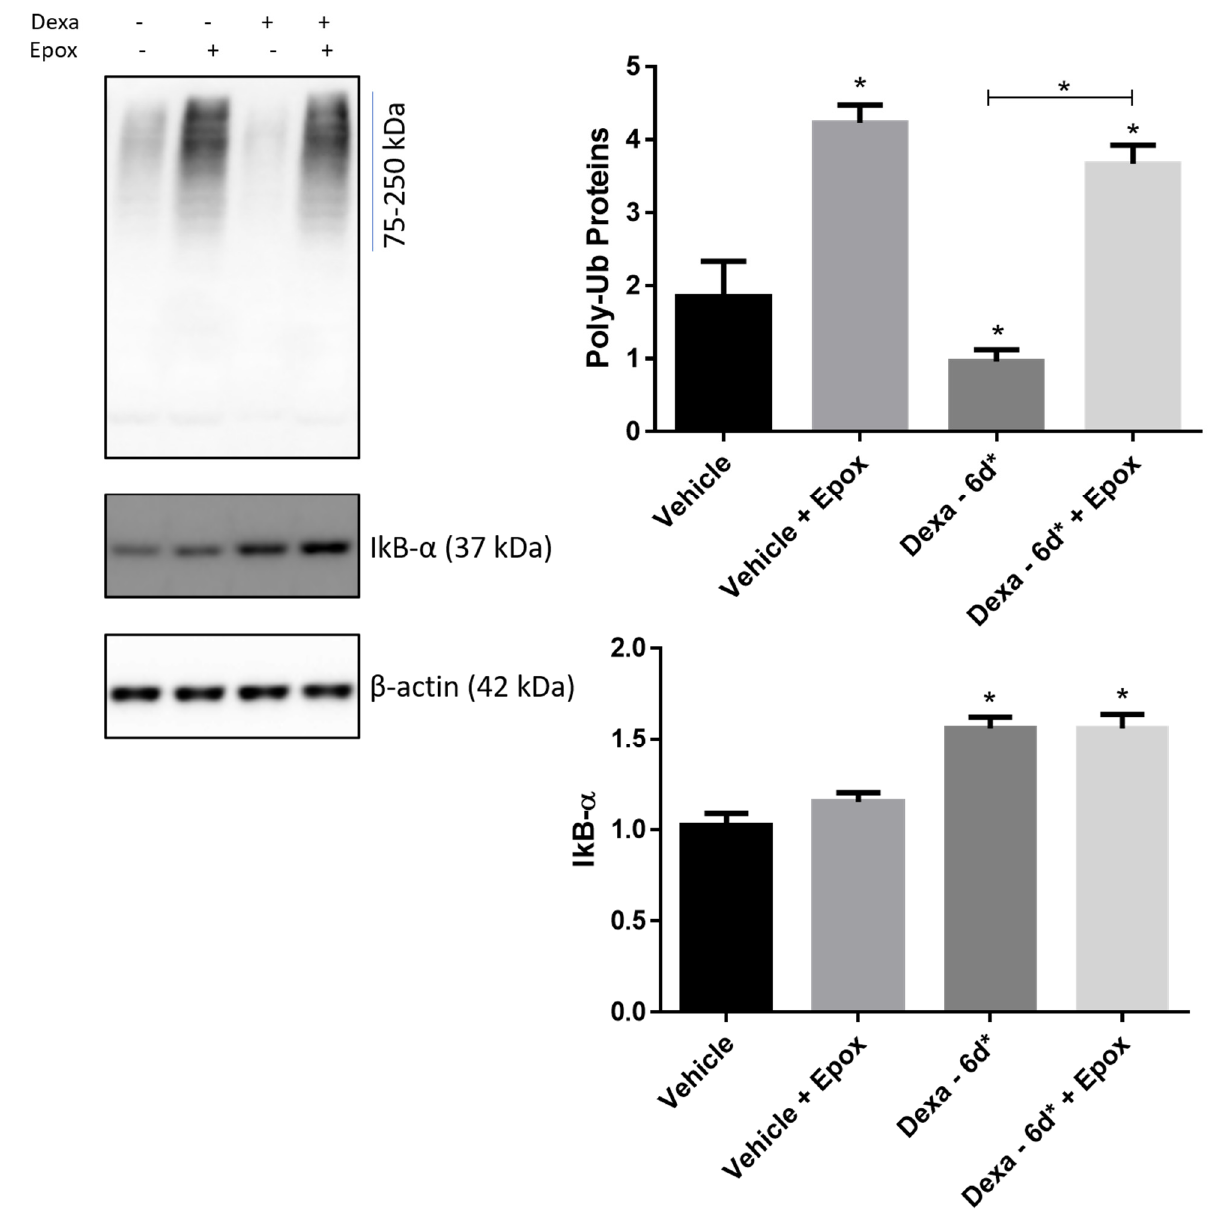
Figure 8. Turnover of poly-Ub protein and IkB α in Dexa-treated TMCs. Immunoblotting of Ub and IkB α in whole cell lysates of TMCs. β -actin was used as internal control. A representative experiment of three independent observations is reported ( n = 3); * p < 0.0001; one-way ANOVA followed by Tukey’s post hoc significance test.